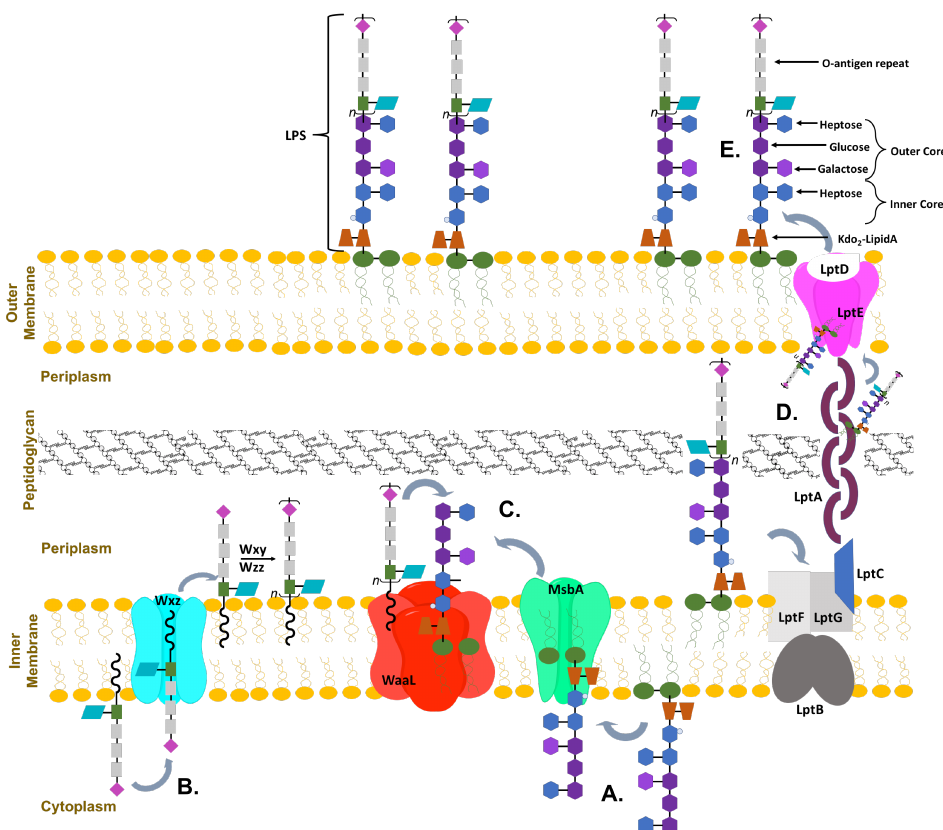
Figure 1. Representative organization of Gram-negative bacterium from Escherichia coli